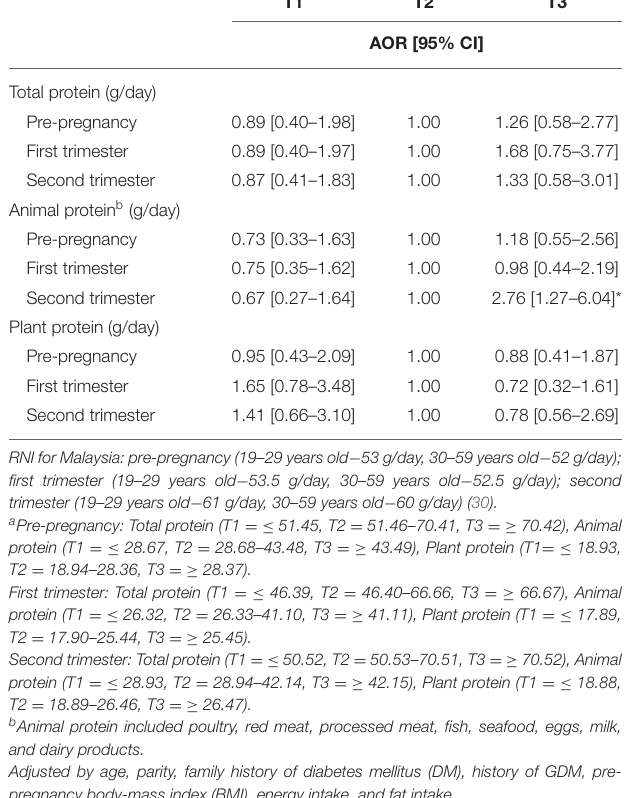
TABLE 4 | Adjusted odds ratio (AOR) and 95% CI for the associations between TABLE 3 | Adjusted odds ratio (AOR) and 95% CI for associations between the the animal protein sources and GDM. total and types of protein intake with GDM. Intake tertile a Source of animal protein Intake T1 T2 T3